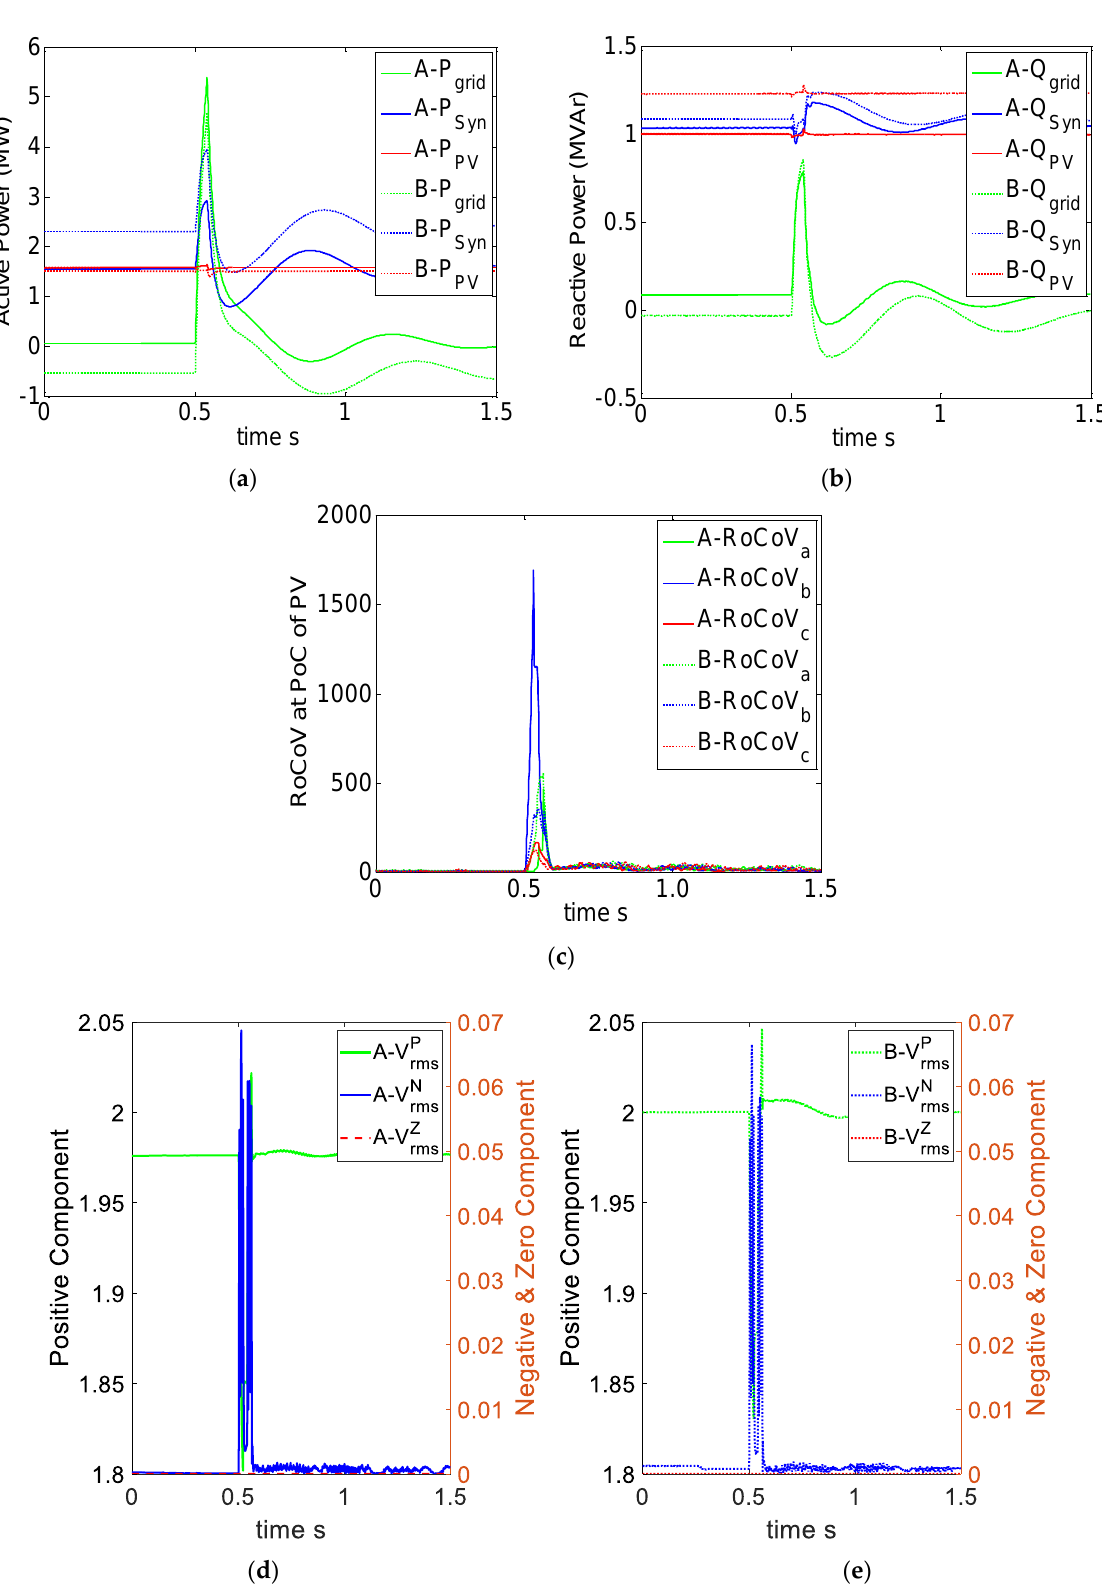
Figure 10. Three-phase to ground fault case study ( a ) Active power generation of DGs and grid for case 3, scenario A and B; ( b ) Reactive power outputs of DGs and grid for case 3, scenario A and B; ( c ) Rate of change of voltages at the PoC, scenario A and B; ( d ) Symmetrical component of the voltage at the PoC, scenario A; ( e ) Symmetrical component of the voltage at the PoC, scenario B.